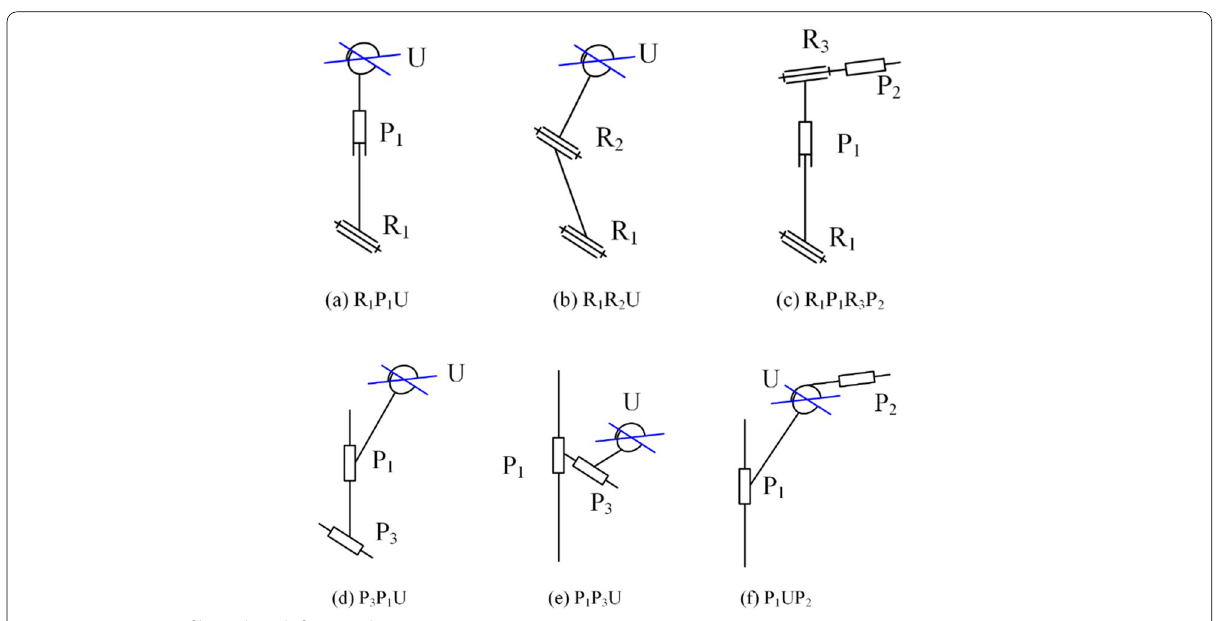
Figure 3 Six types of branch with four single joints in Case 1